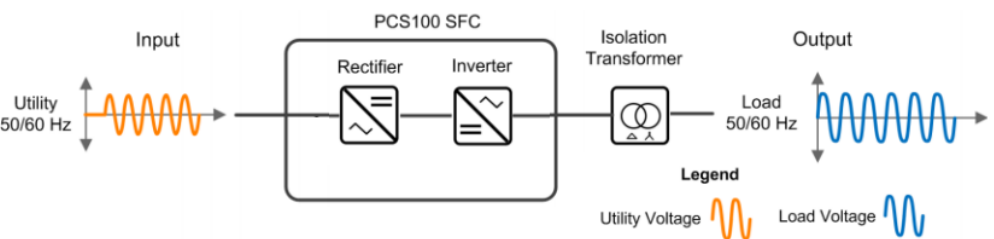
Figure 5. Simplified electrical layout of B2B Converter (ABB PCS100